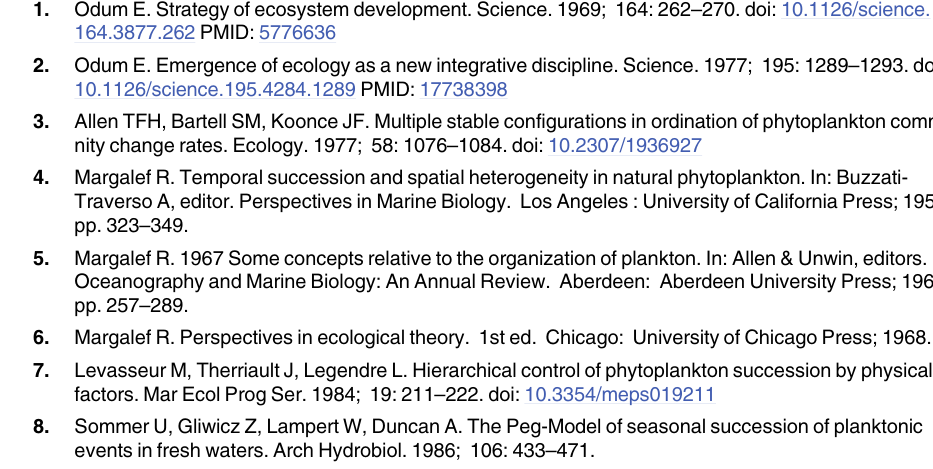
S1 Table. Indicator values ( IV ) outputs for each of the 4 biological clustering levels, for 1 every PEC. Clusters are identified with the same terminology and colour coding as in Figs. 1, 2 and 3. IVs and significance levels of p-values are shown besides each plankton group. 3 Groups, IV and p-values printed in italics are non-significant. (cid:3) , (cid:3)(cid:3) and (cid:3)(cid:3)(cid:3) stand for p < 0.05, p < 0.01, and p < 0.001,